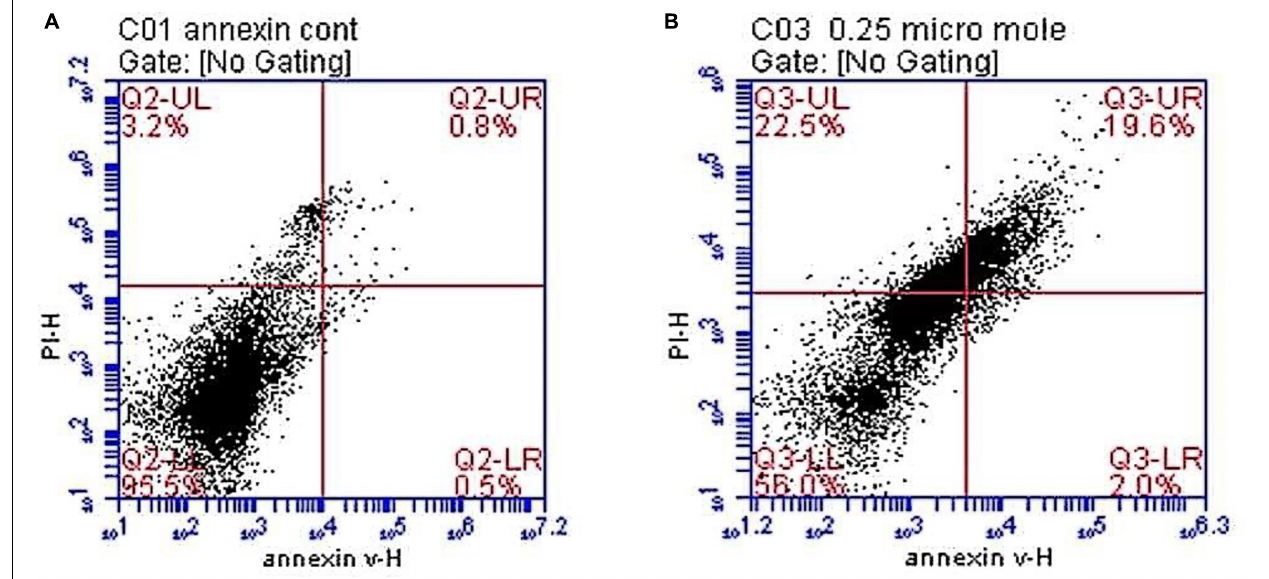
FIGURE 3 | Histograms showing flowcytometric analysis of the neuronal cell cultures in control and test groups. (A) A histogram showing that most of the neurospheres are viable in the control group. (B) A histogram showing decreased cellular viability, increased necrosis, early and late apoptosis in neurospheres exposed to trichloroethylene (TCE) 0.25 µ M [viable cells in the lower left quadrant (LL), early apoptotic cells in the lower right (LR) quadrant, late apoptosis is seen in the upper right (UR) while necrosis is shown in the upper left (UL) quadrants].